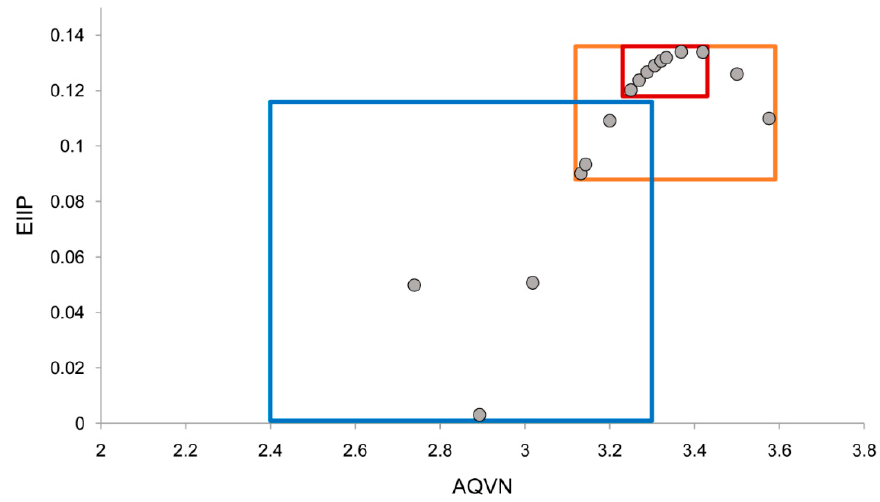
Figure 1. Schematic representation of the EIIP/AQVN criterion for selection of candidate Leishmania arginase inhibitors. Extended active group (orange): AQVN (3.13–3.58), EIIP (0.09–0.134). Core active group domain (red): AQVN (3.25–3.42), EIIP (0.12–0.134). Chemical space (blue) AQVN (2.40–3.30) EIIP (0.000–0.116) EIIP/AQVN domain of homologous distribution of >90% compounds from the